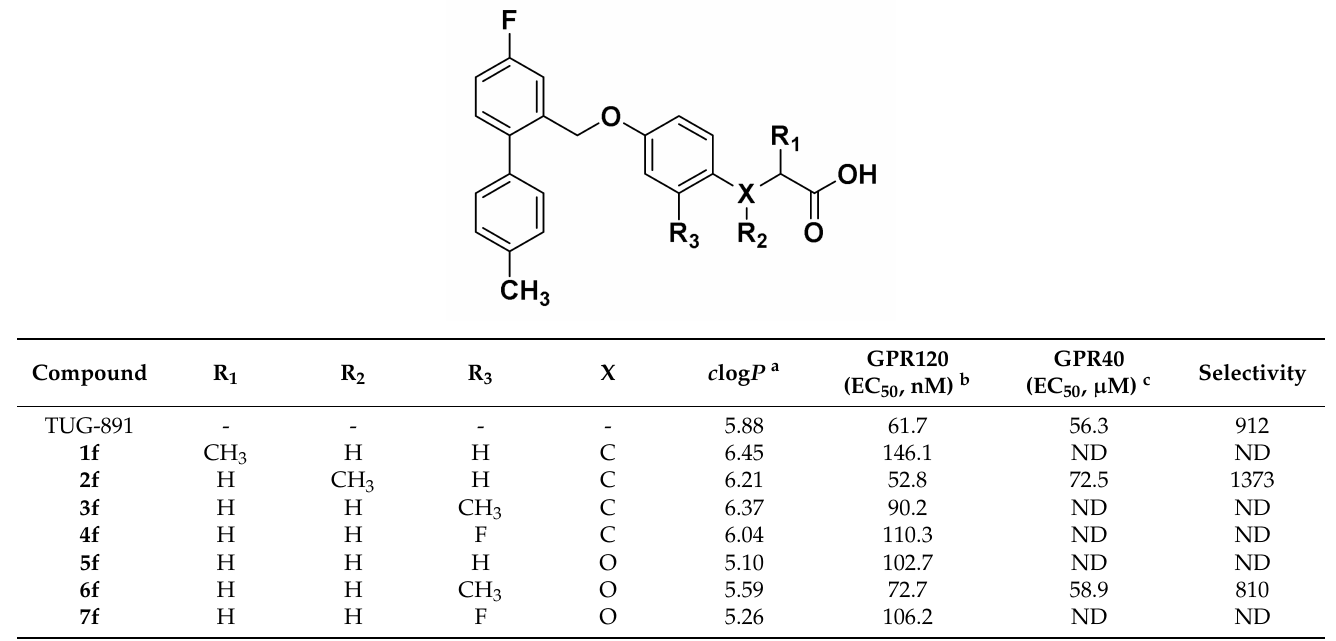
Table 1. In vitro activities and selectivity of target compounds 1f – 7f